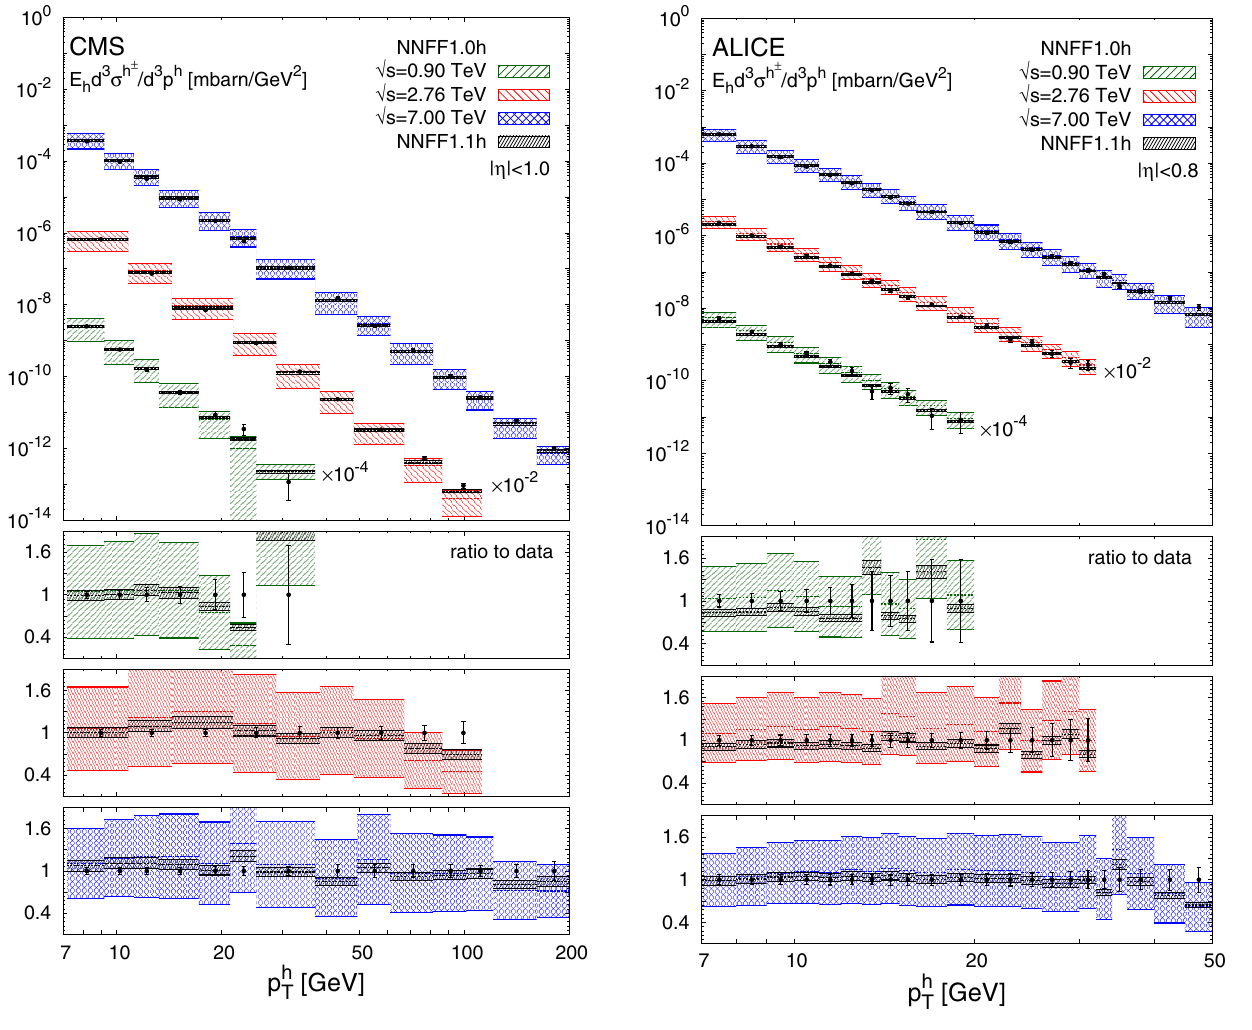
Fig. 5 Same as Fig. 4 for the ALICE data sets / N ALICE 0.9 TeV data sets, the χ 2 dat increases from 1.40 rw and 1.52 to 2.01 and 2.56, respectively, when one lowers the cut from 10 GeV to 5 GeV. The description of the ALICE 2.76 TeV and 7 TeV data is instead moderately better with = 5 GeV than the one with p h = 10 GeV. p h T , cut T , cut Theoverallfitqualityturnsouttobeverysimilarforvalues larger or equal to 6 GeV. Conversely, it markedly of p h T , cut worsens when we lower the value of p h from 6 GeV to T , cut / N 5 GeV. In this case, the χ 2 dat increases from 1.14 to rw 1.27, mostly because of the poor description of the 1.8 TeV / N CDF data set, whose χ 2 dat raises from 0.28 to 1.30. A rw / N deterioration is also observed in the χ 2 dat of almost all rw the other data sets; in particular, it increases from 0.67 to 0.93 and from 2.05 to 2.56 for the 0.9 TeV CMS and ALICE data sets